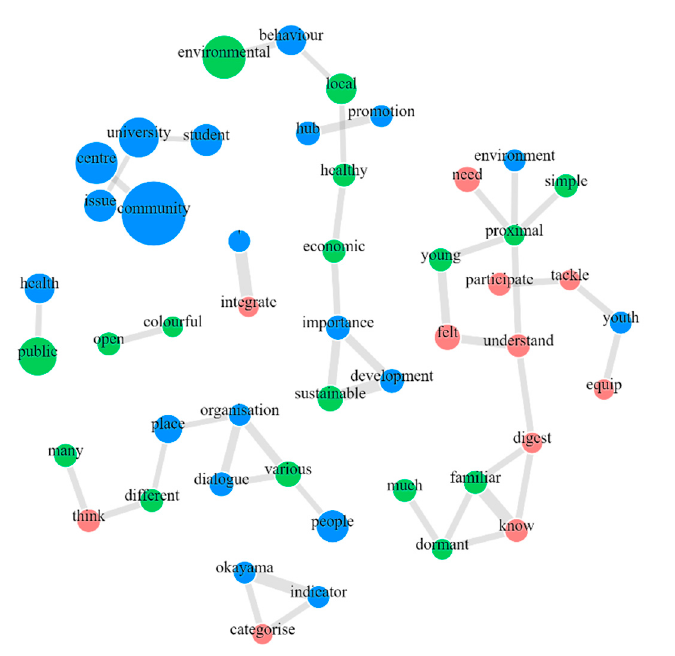
Figure 5. Hierarchical clustering.